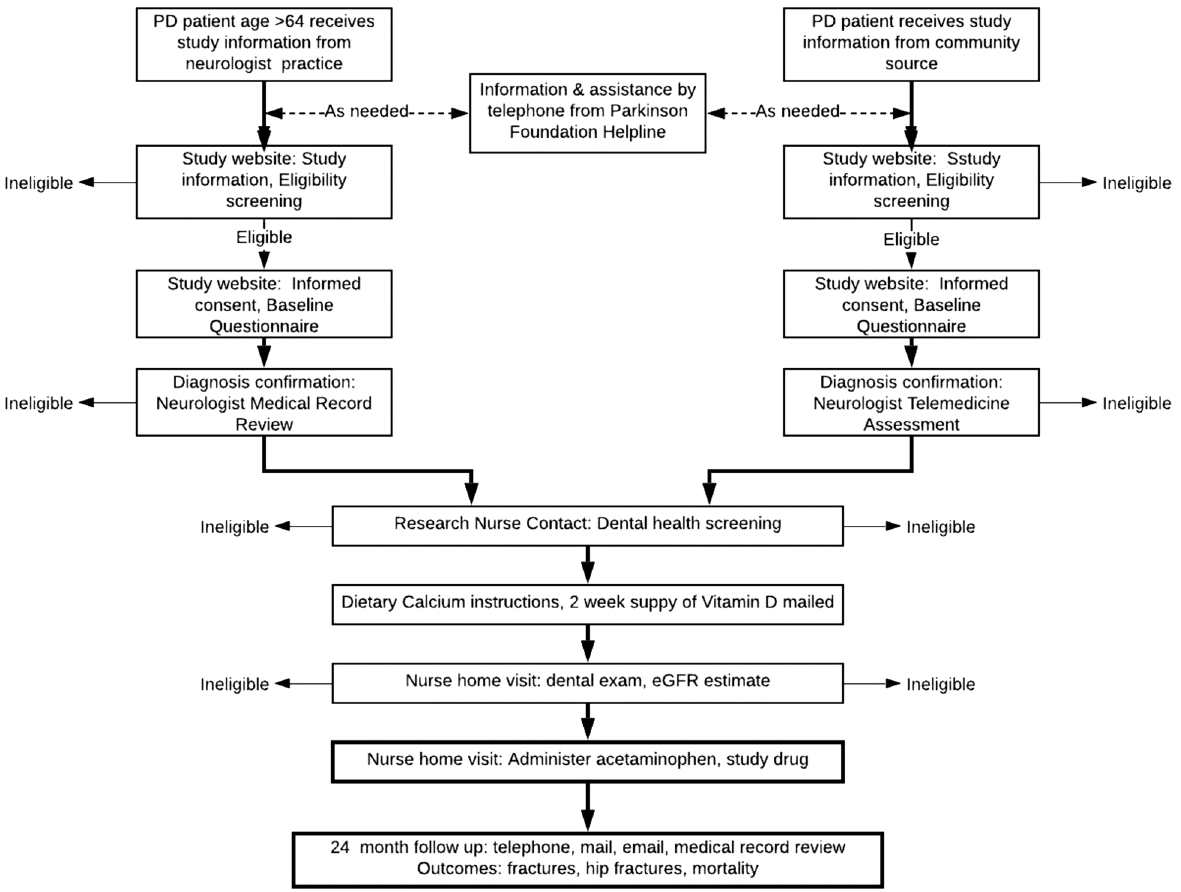
Fig. 2 Flow of Participation in TOPAZ Study. Participants may self-refer or be referred by neurologists. Informed consent is provided online and treatment is provided in the home. Followup isconducted